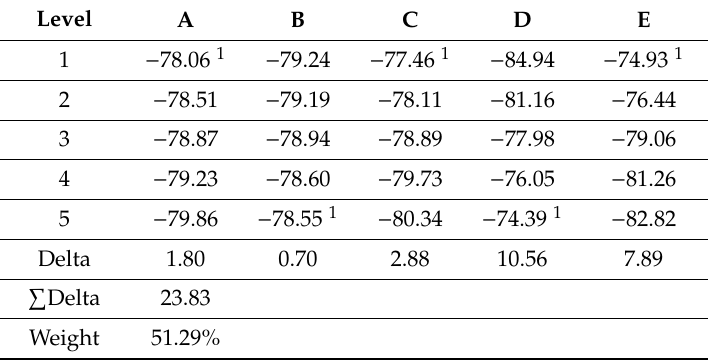
Table 9. Factorial e ff ects and weight factors for the pressure